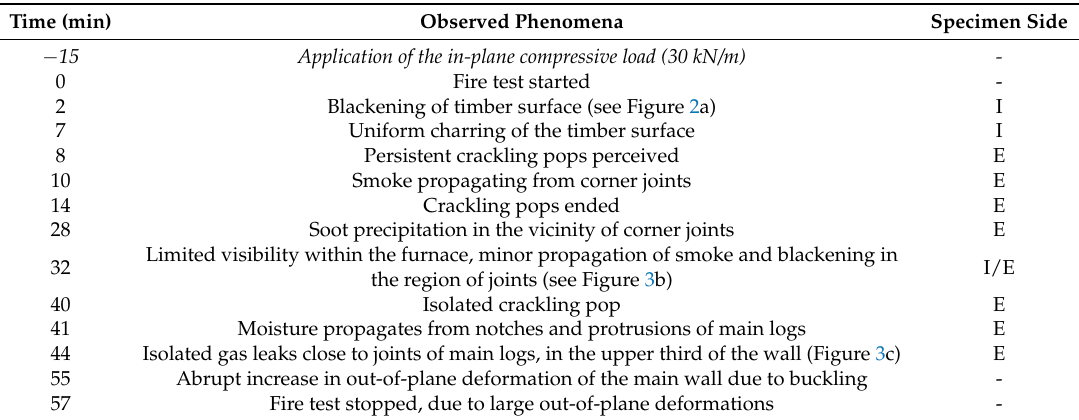
Table 2. Experimental visual observations for the W80 full-scale test.